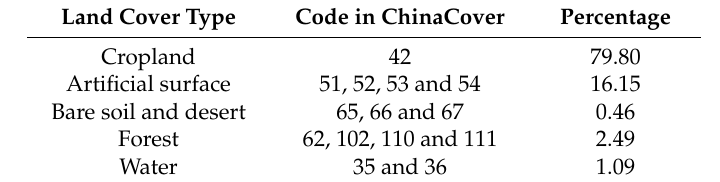
Table 2. Percentages of different land cover types in Guantao County provided by ChinaCover.